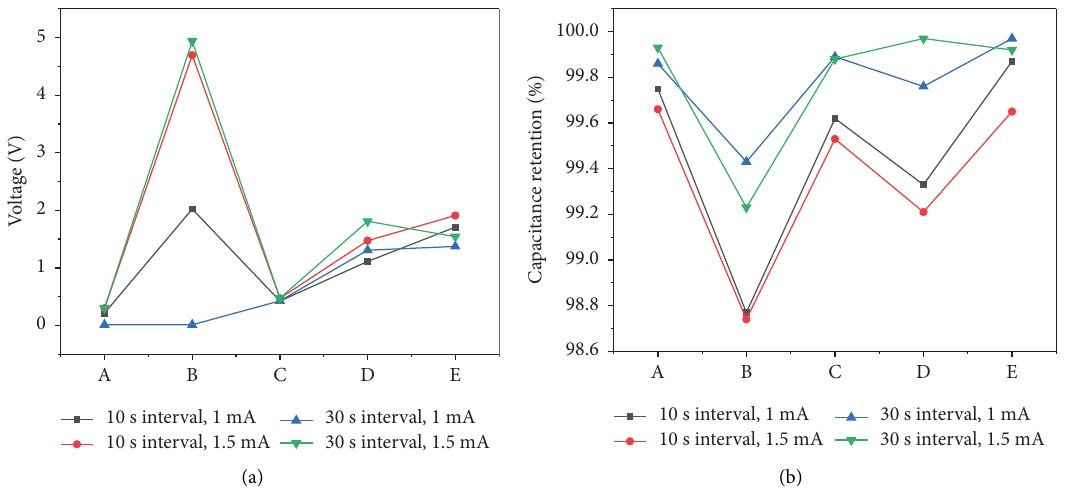
Figure 10: (a) Voltage drop; (b) capacitance retention. A: freeze-dried MWCNT-reinforced IPMC; B: freeze-dried common IPMC; C: MWCNT-enhanced IPMC; D: ordinary porous IPMC; E: common